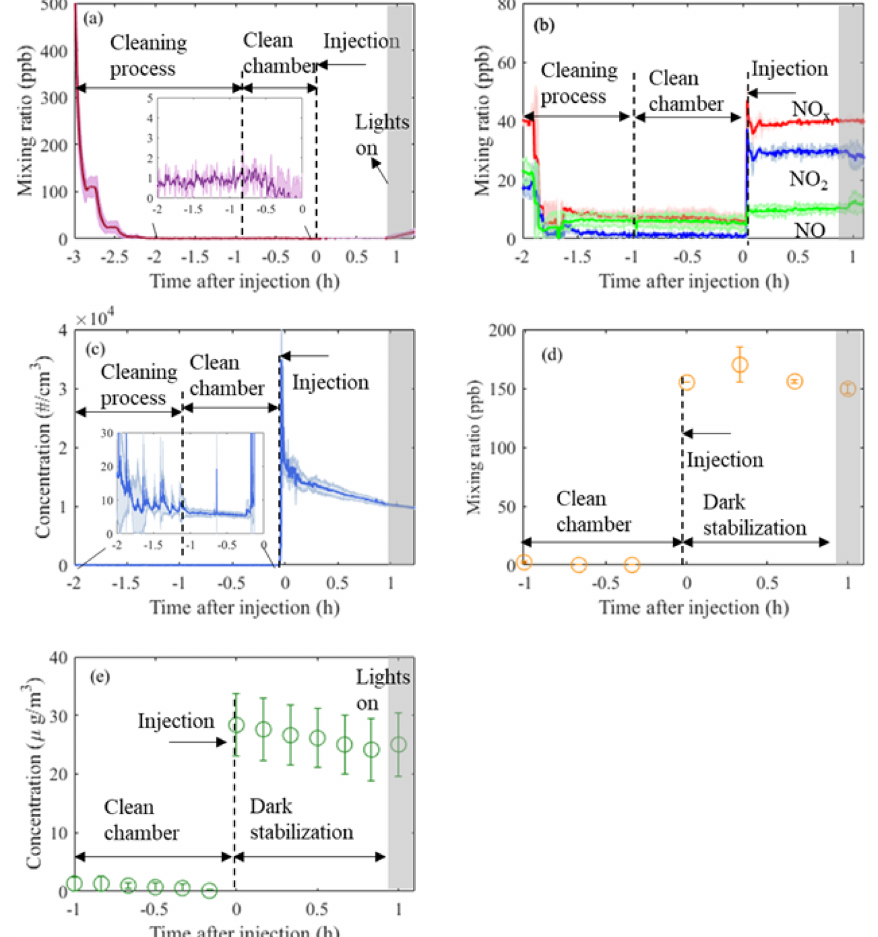
Figure 2. Time series (mean ± 1 σ , n = 3) of O 3 (a) , NO x (b) , particle number (c) , VOC ( α -pinene; d ), and particle mass (e) from three identical experiments conducted in the MAC. Annotations provide information of the related process occurring in the chamber at each time point, normalised to the injection time of the reactants. Cleaning process duration is ∼ 2h, while subsequently the chamber is left with clean air for about 1h prior to the addition of the reactants (“clean chamber”). After the addition of the reactants, the chamber is stabilised in the dark for another hour (“dark stabilisation”) before the lights are turned